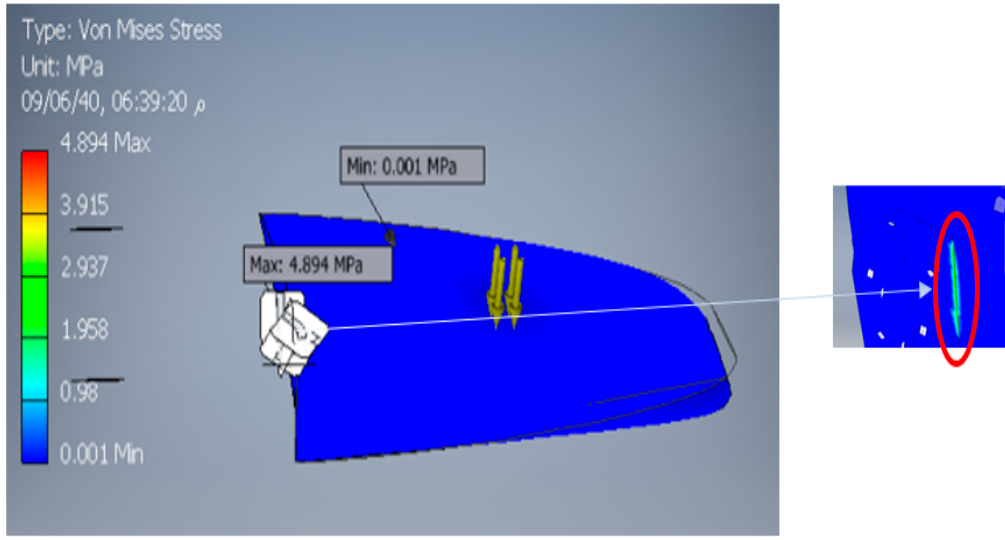
Figure 3. Von Mises stress distribution in the blade and stress contours.